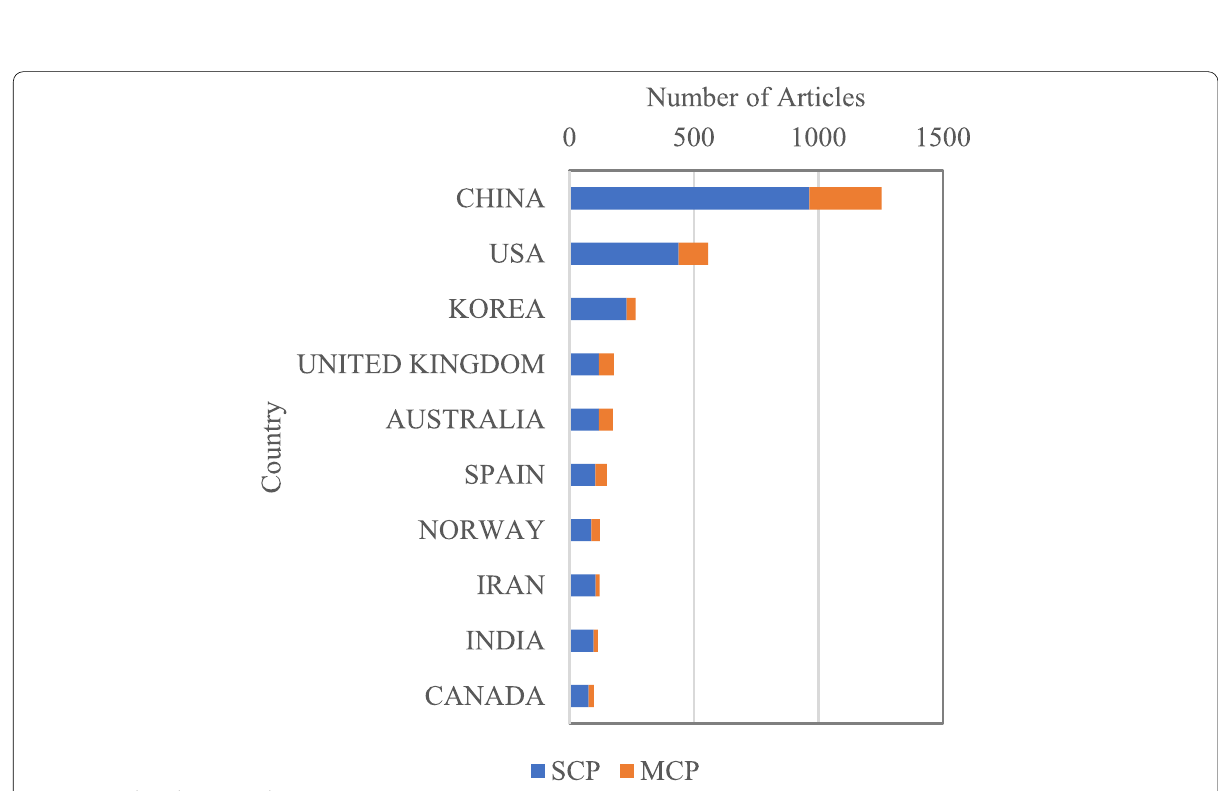
Fig. 22 Combined, top contributing